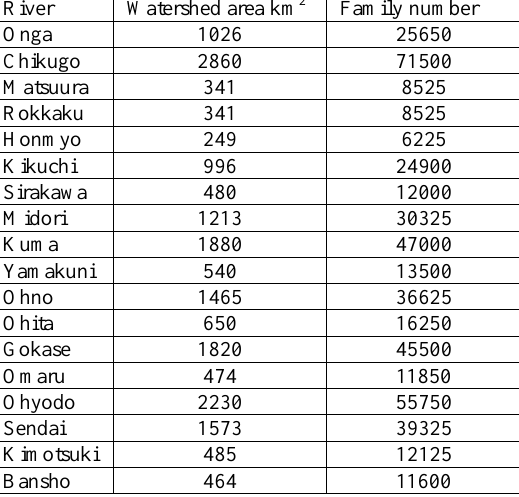
Table 1. List of Kyushu rivers